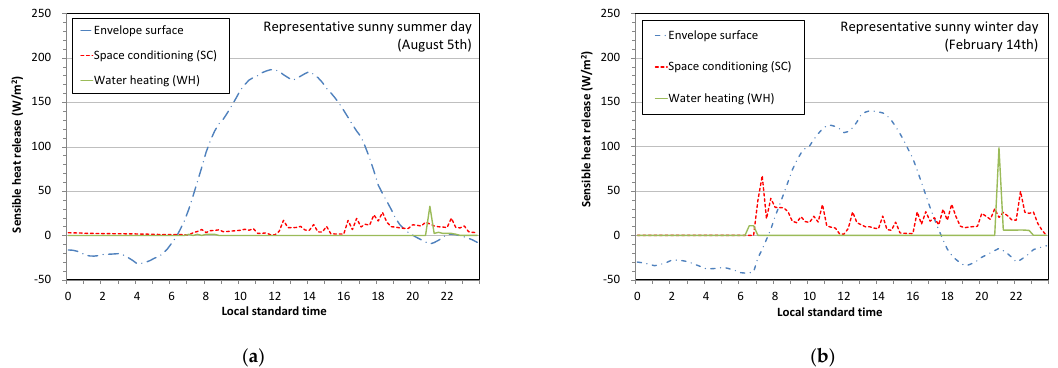
Figure 4. Sensible heat release from each path for a wooden structure with low insulation on a representative sunny day in ( a ) summer and ( b ) winter.